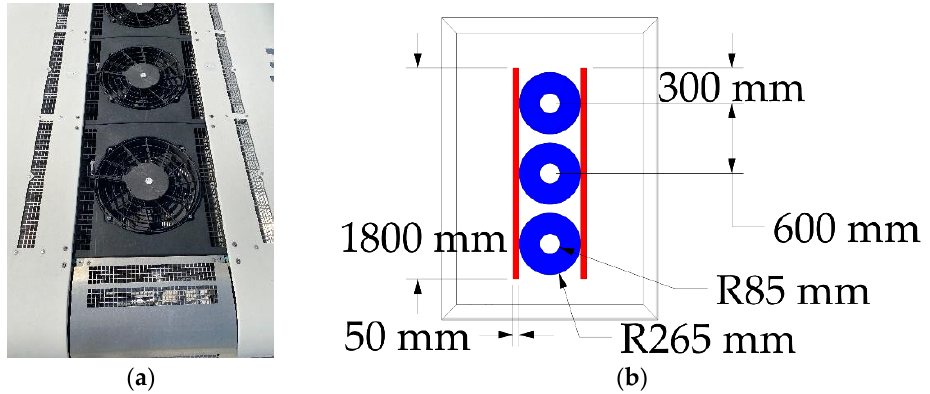
Figure 2. Openings of the air conditioning unit ( a ) photo and ( b ) schematic.